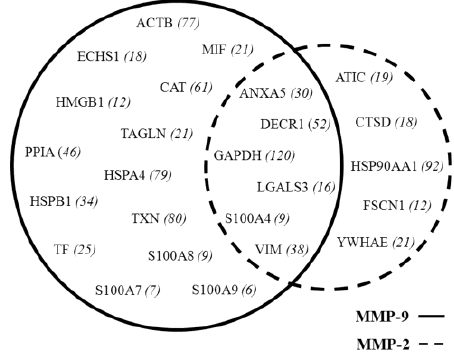
Figure 6. Venn diagram representing the predicted direct interactions of MMP-9 and MMP-2 with protein identities within the 274 entries identified in the proteomic profiles of the 80 selected breast cancer tissues. The intersection of the two circles includes six identities shared by the two MMPs. In brackets are the reported second-level interactors for each putative partner.